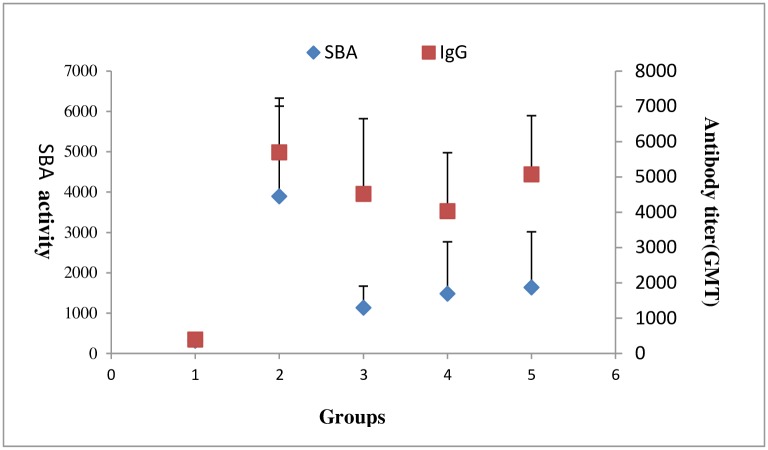
SBA activity and anti-GAMP antibody levels of conjugated and unconjugated GAMP, showing a consistent trend and positive correlation between the two groups (R = 0.604, P < 0.05).The results of SBA and anti-GAMP total IgG were expressed as the reciprocal of geometric mean titer (GMT). The 1–5 numbers on the horizontal axis represent Group GAMP, GAMP-PspA1, GAMP-PspA2, GAMP-PspA3 and GAMP-TT, respectively.